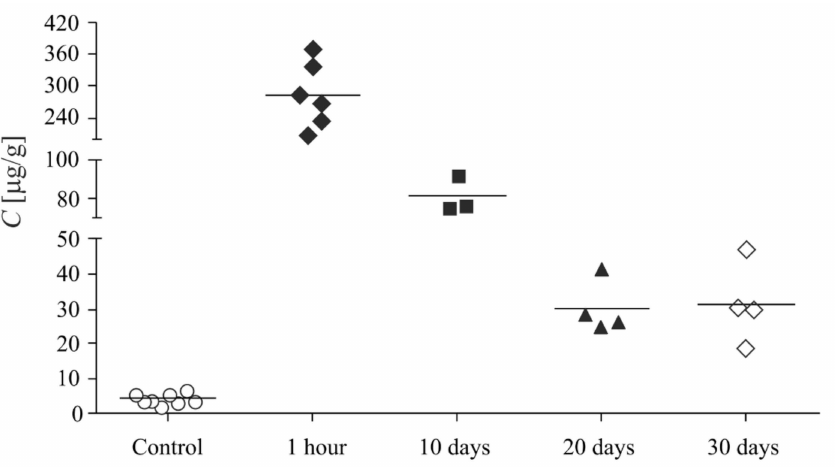
Figure 10. Silicon content ( C ) in the liver of animals at different times after the introduction of silica nanoparticles